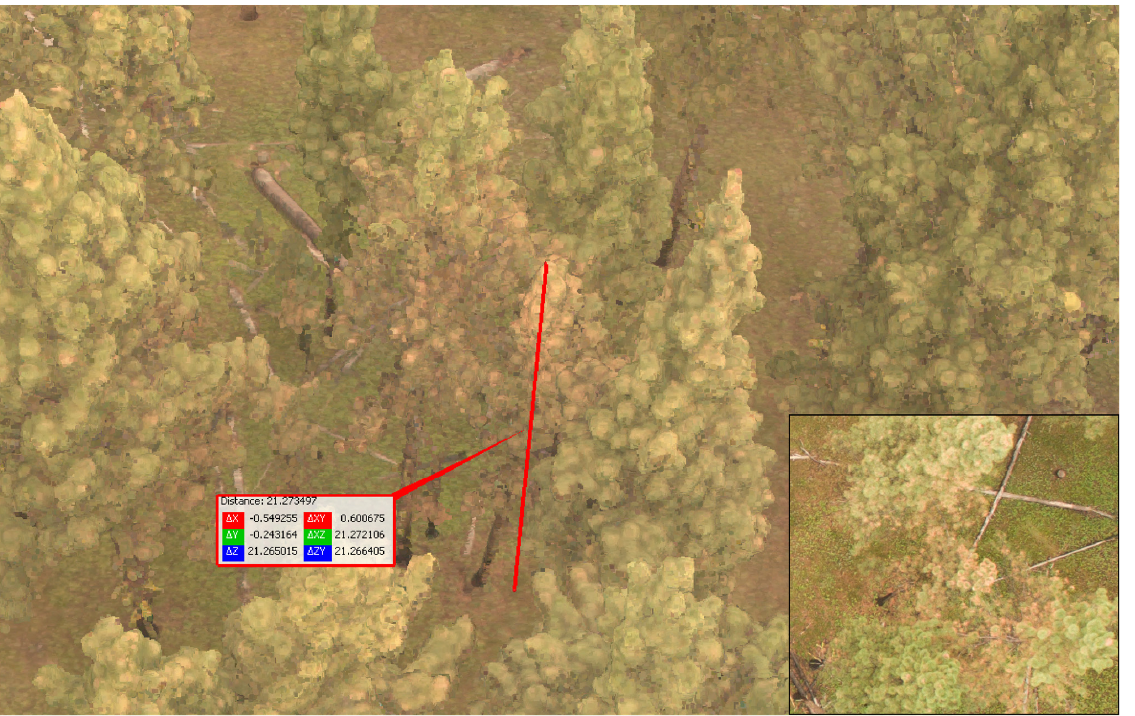
Figure 1. Point cloud derived from structure-from-motion (SfM) photogrammetry using images taken by the DJI X3 RGB camera. The same location is shown using an original X3 image (inset bottom-right). The red line depicts the process of manually identifying and measuring scorch height within CloudCompare software. The digital measurements were taken at the same locations as the field measurements to assess the ability to accurately map scorch.